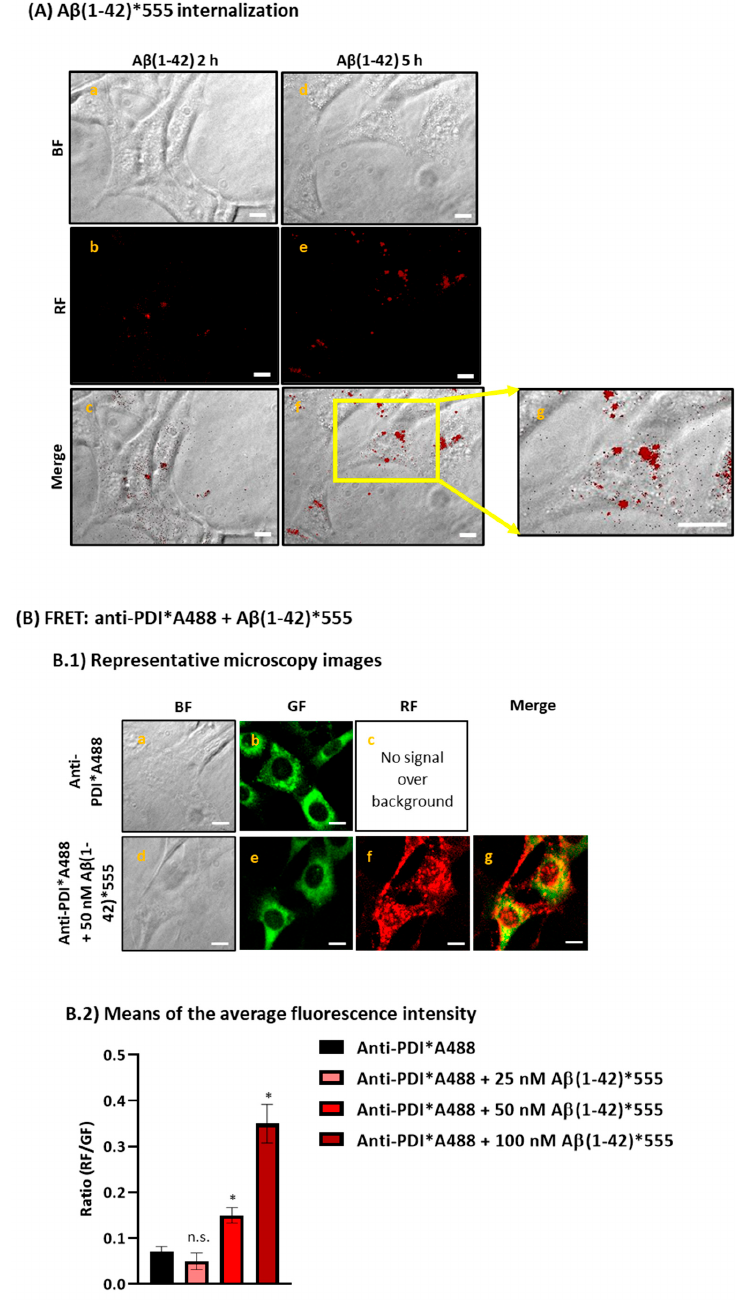
Figure 1. Internalization of A β (1-42)*555 after 2 h and 5 h incubation in living HT-22 cells and extensive FRET between anti-PDI and A β (1-42)*555 in fixed and permeabilized HT-22 cells. Panel ( A ): HT-22 cells were incubated with 2 µ M A β (1-42) (1.8 µ M of unlabelled A β (1-42) plus 0.2 µ M of A β (1-42)*555) for 2 h and 5 h at 37 ◦ C and 5% CO 2 . Figure 2A(a–c) shows representative images of bright field (BF), red fluorescence (RF), and Merge (BF plus RF) of HT-22 incubated for 2 h with A β (1-42). Figure 2A(d–f) shows representative images of BF, RF, and merge of HT-22 cells incubated for 5 h with A β (1-42). Figure 2A(g) shows a focalized zoom of Figure 2A(f) to highlight the subcellular distribution of A β (1-42)*555 near the perinuclear region of HT-22 soma. Scale bar inserted in fluorescence microscopy images = 20 µ m. Panel ( B ): high co-localization between anti-PDI and A β (1-42)*555 as shown by the representative fluorescence microscopy images of HT-22